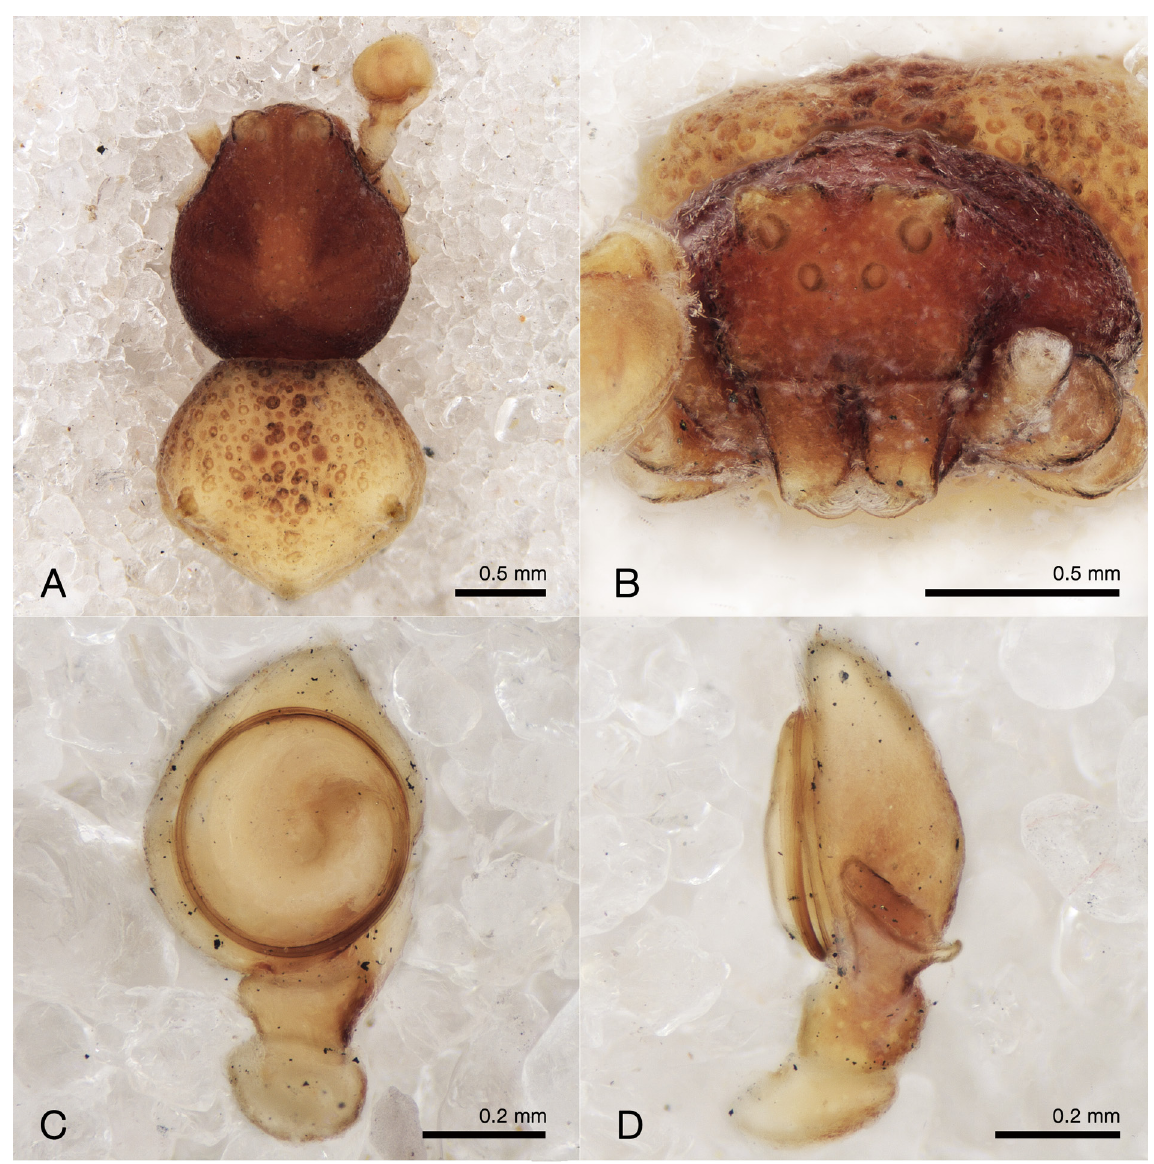
Fig. 23. Stephanopis aheneus Soares & Soares, 1946. Holotype (MZSP 666). A . Habitus, dorsal view. B . Front. C–D . Left palp. C . Ventral view. D . Retrolateral